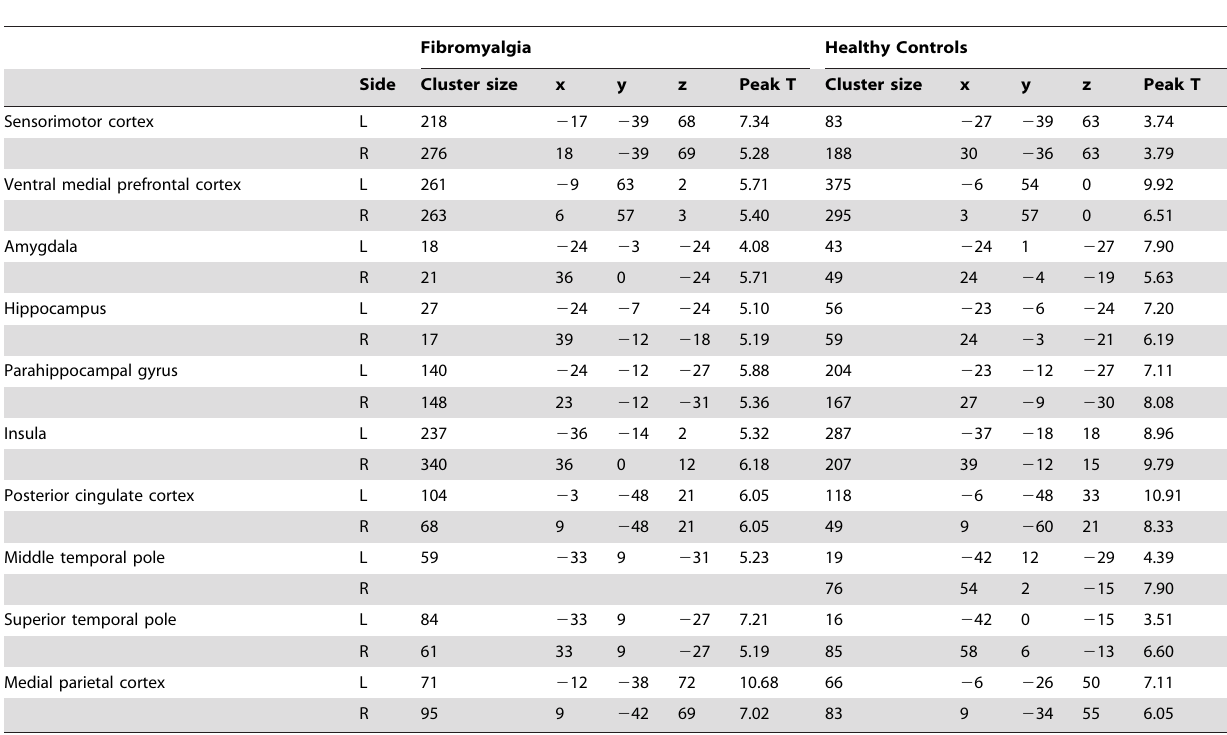
Table 4. 2-back minus 0-back deactivation one sample t-test (FDR corrected for multiple comparison, P , 0.01 and minimum cluster size of 64).